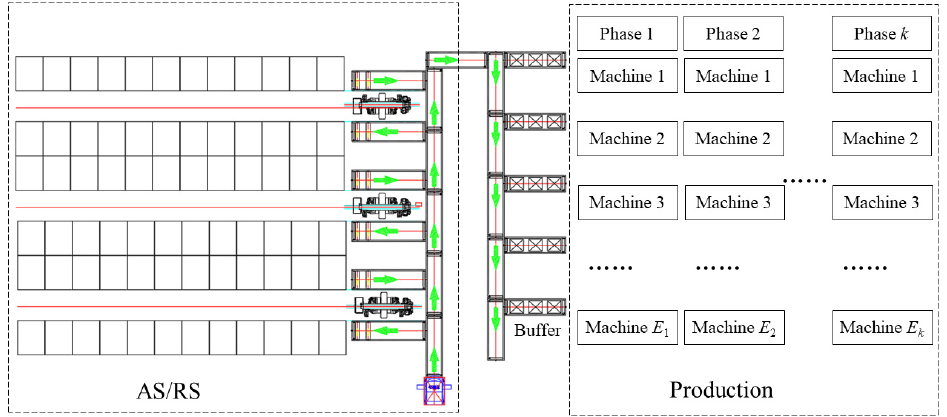
Figure 2. Material distribution diagram in AS/RS and hybrid flowshop.